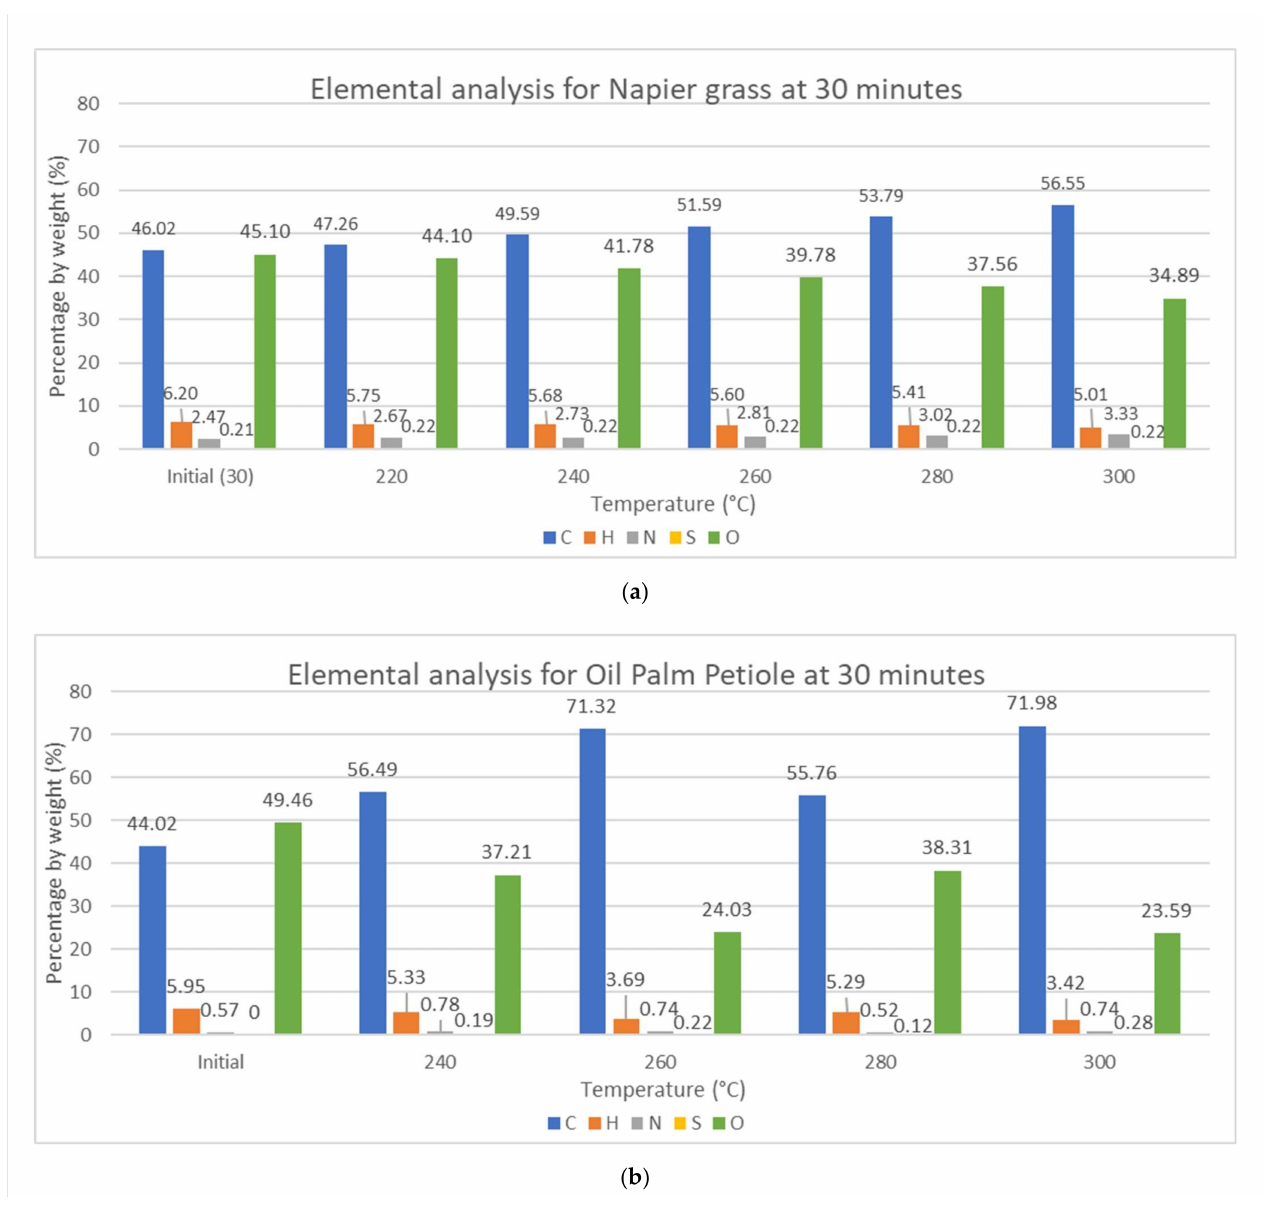
Figure 2. Elemental analysis at reaction time of 30 min for ( a ) Napier grass and ( b ) oil palm